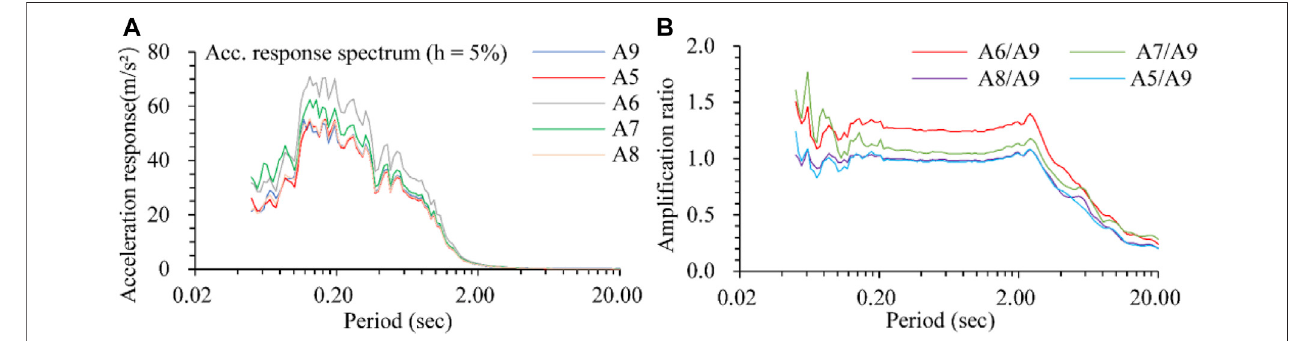
FIGURE 13 | Responsive peak acceleration contours for different excitation waves (unit: m/s 2 ).